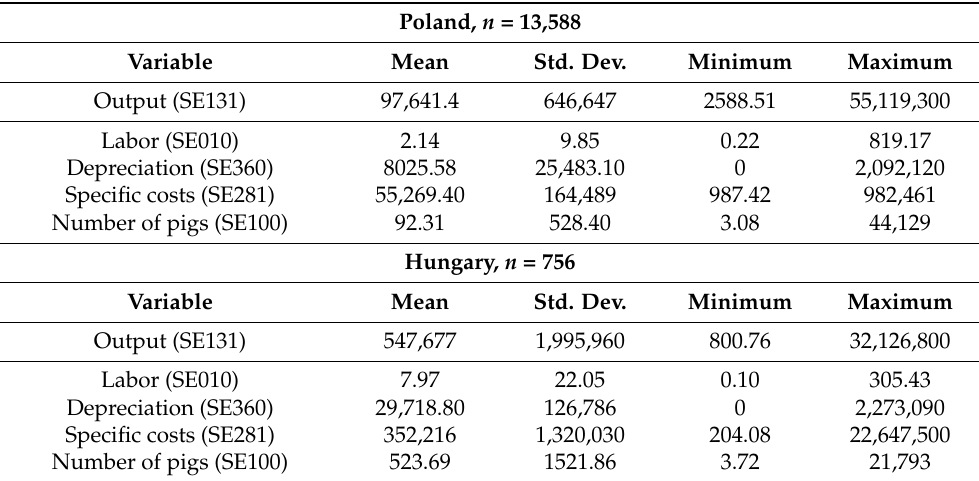
Table 2. Descriptive statistics for the research sample.